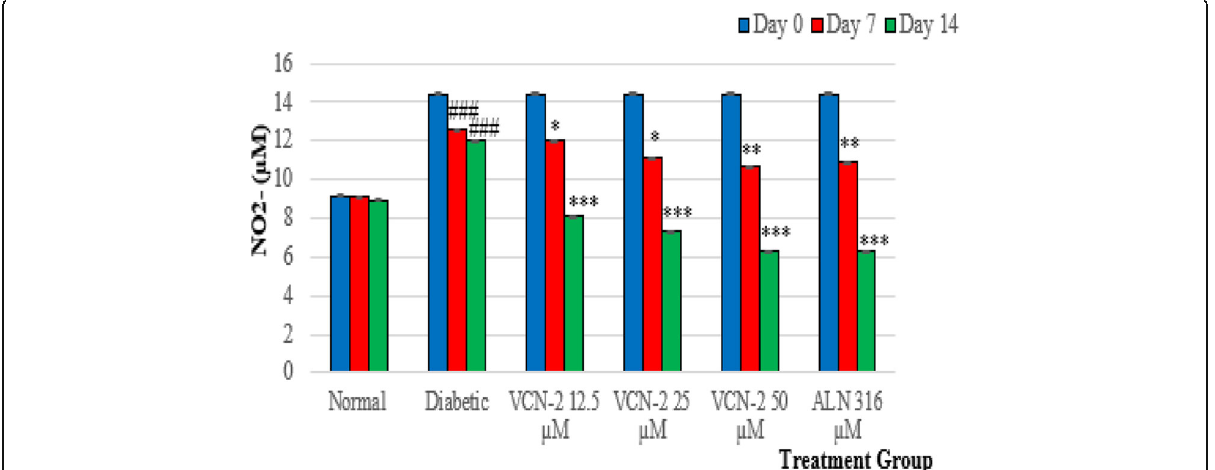
Fig. 4 Nitrite levels. On 0, 7, and 14 postoperative days, animals were sacrificed and samples of excisional wounds were removed to determine nitrite levels by Griess reaction. Data are mean of three independent experiments and are expressed as mean±SEM of nitric oxide levels ( μ M). ### p <0.001 indicated statistical difference diabetic group compared to normal group; * p <0.05, ** p <0.01 and *** p <0.001 indicated treatments groups with respect to diabetic group. ( n =6 animals/group/time point/experiment, ANOVA-Tukey